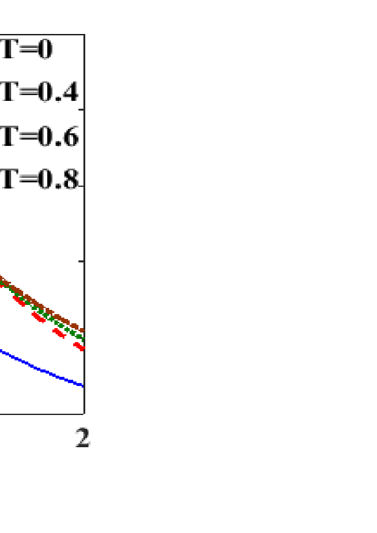
Figure 4. L n versus (cid:31) for different k B T at γ = 0.02